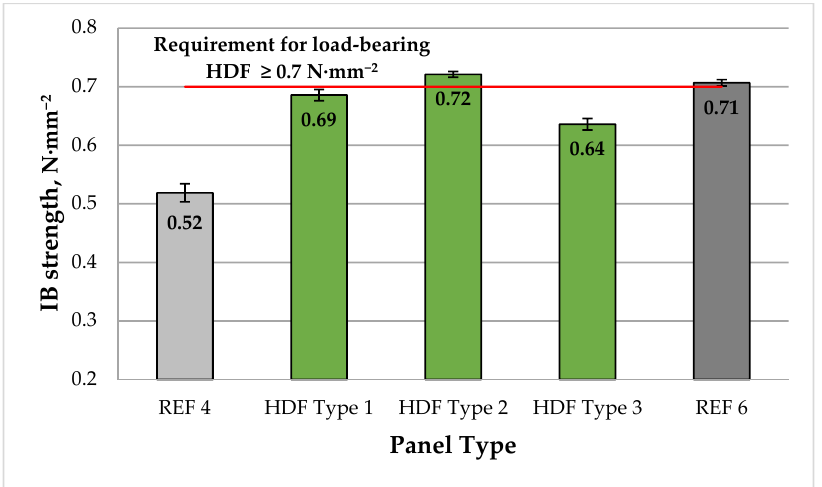
Figure 6. Internal bond (IB) of HDF panels produced. REF 4: 4% UF resin; HDF Type 1: 4% UF resin and 4% ALS; HDF Type 2: 4% UF resin and 6% ALS; HDF Type 3: 4% UF resin and 8% ALS; and REF 6: 6% UF resin. (Error bar represents the standard deviation, and the red line represents the EN 622-5 standard requirement for panels for use in load-bearing applications [102].). The IB values of HDF panels varied from 0.52 to 0.72 N·mm − 2 . The addition of 4% ALS to the UF resin resulted in significantly improved IB values by approximately 33% compared with the control panel bonded with 4% UF resin and without ALS (REF 4).